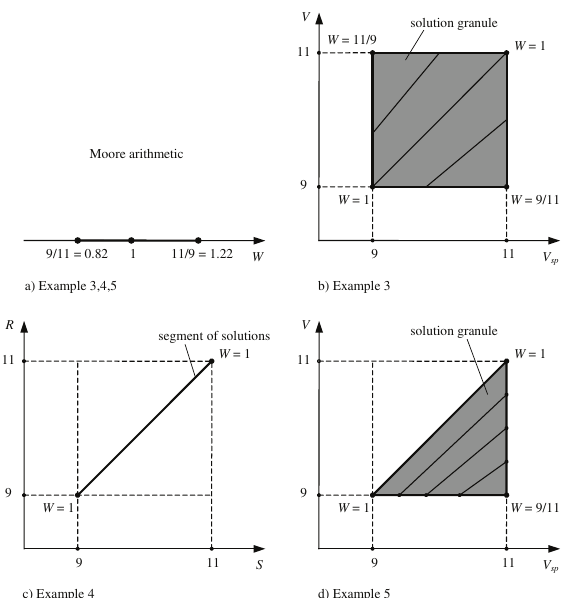
Fig. 15. Solution granules of the ‘same’ IPVs division task obtained in Examples 3, 4 and 5 with the Moore arithmetic (a) and with the RDM-arithmetic (b,c,d).